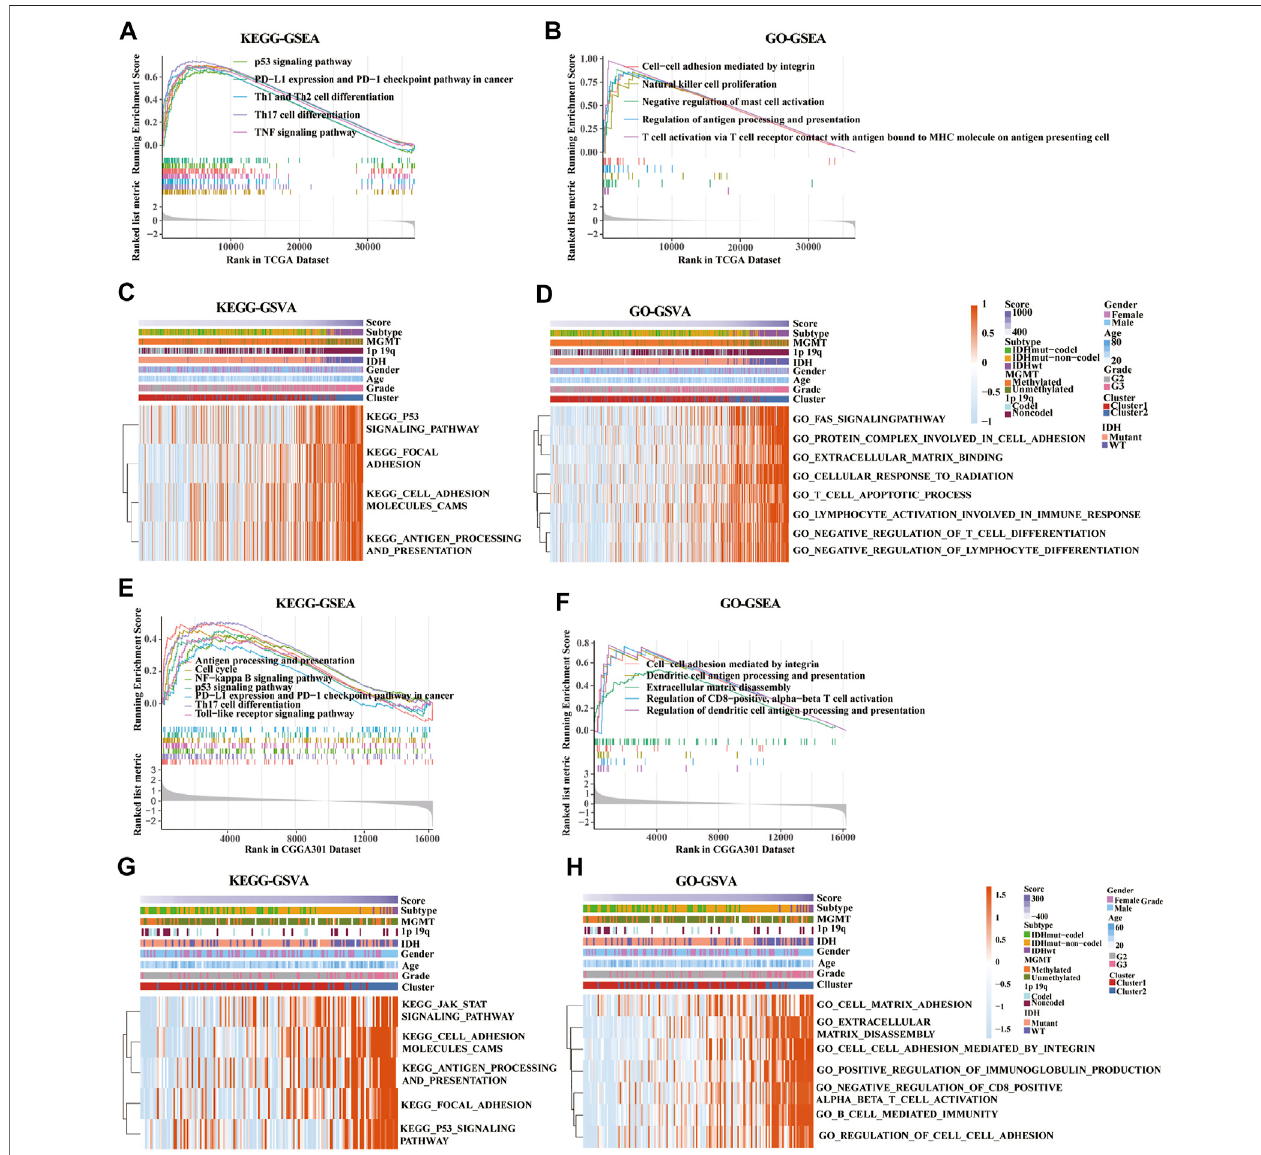
FIGURE 7 | Gene set enrichment analysis (GSEA) and gene set variation analysis (GSVA) of key pathways between low-risk and high-risk groups based on gene ontology (GO) and Kyoto Encyclopedia of Genes and Genomes (KEGG) databases. (A,E) Enriched pathways between low-risk and high-risk groups based on KEGG- basedGSEAanalysisinTCGA (A) andCGGA301 (E) databases. (B,F) Enrichedpathwaysbetweenlow-riskandhigh-riskgroupsbasedonGO-basedGSEAanalysisin TCGA (B) andCGGA301 (F) databases. (C,G) Enriched pathwaysbetweenlow-riskandhigh-riskgroupsbasedonKEGG-basedGSVAanalysisinTCGA (C) and CGGA301 (G) databases. (D,H) Enriched pathways between low-risk and high-risk groups based on GO-based GSVA analysis in TCGA (D) and CGGA301 (H) databases.